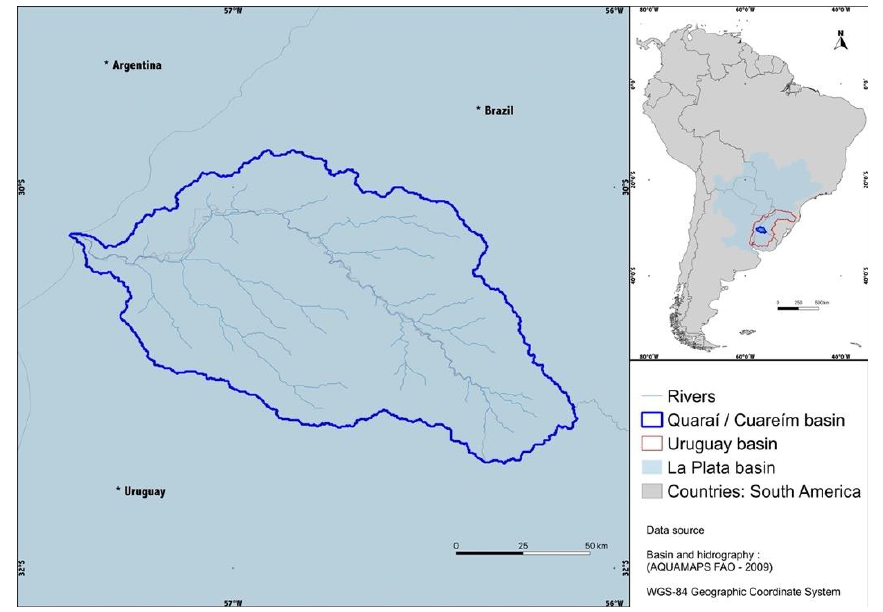
Figure 2. Location of the Quaraí/Cuareim River Basin.